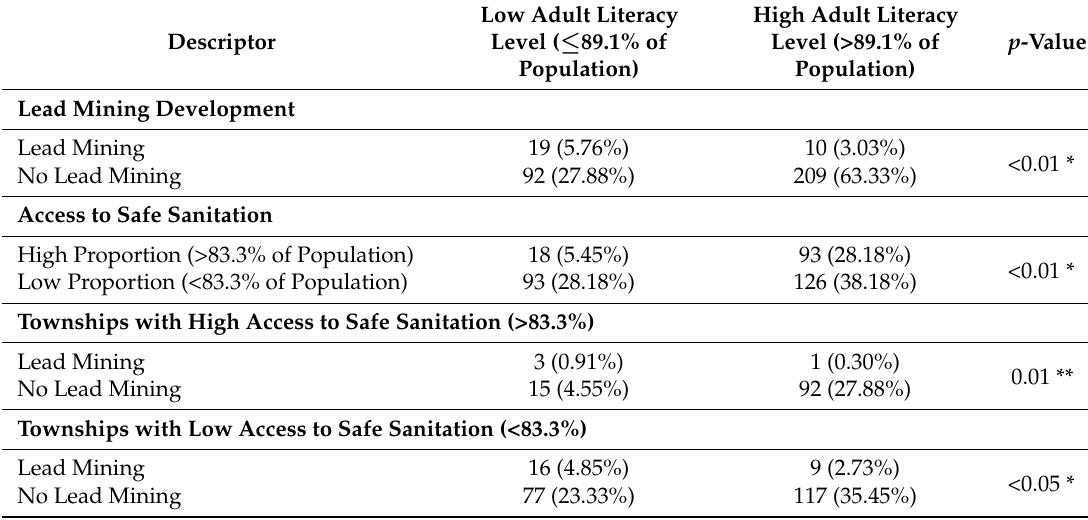
Table 2. Cross Tabulation of Lead Mining Activity and Adult Literacy in Myanmar’s Townships, and the Effect of Access to Safe Sanitation on This Relationship ( n =